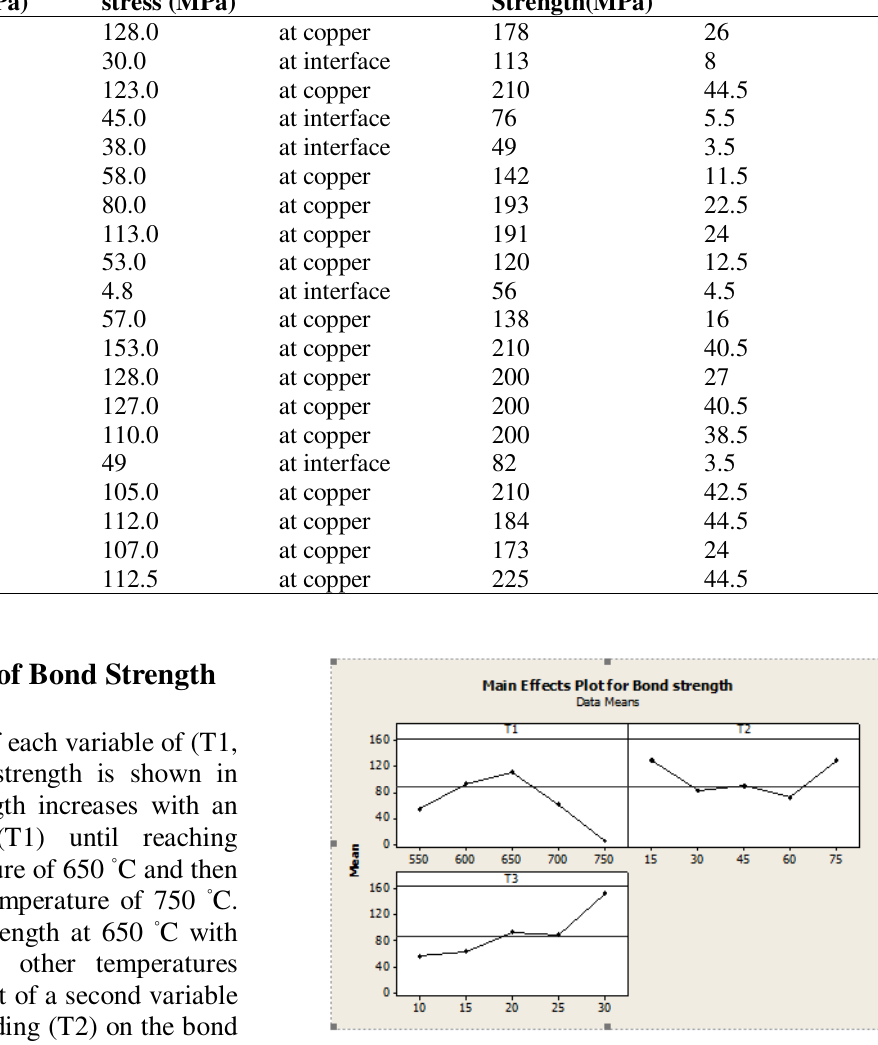
Fig. 5. Main effects on fracture